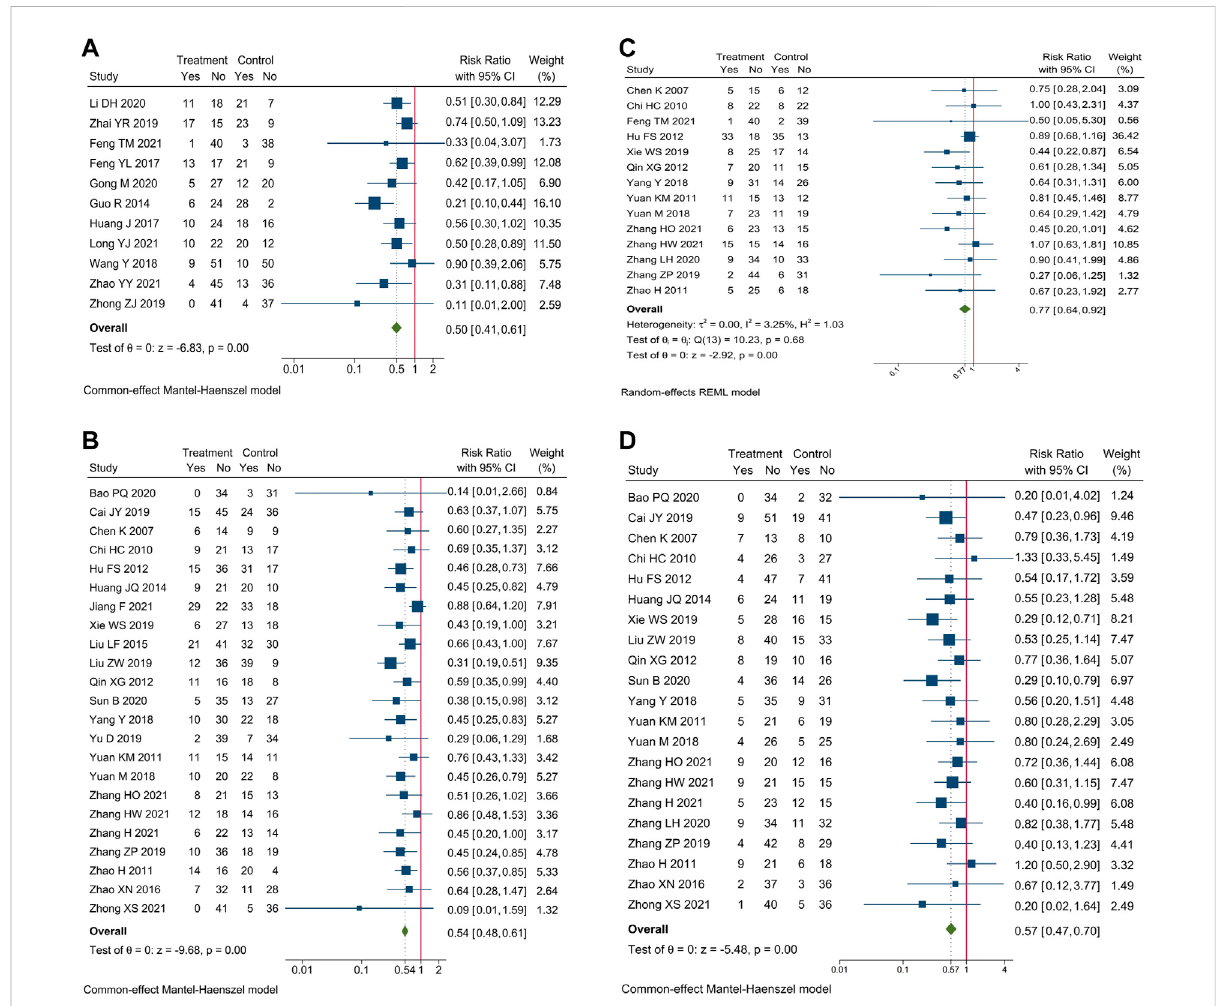
FIGURE 5 Forest plot of incidence of AEs of blood system. Incidence of (A) myelosuppression, (B) leucopenia, (C) anemia, and (D)